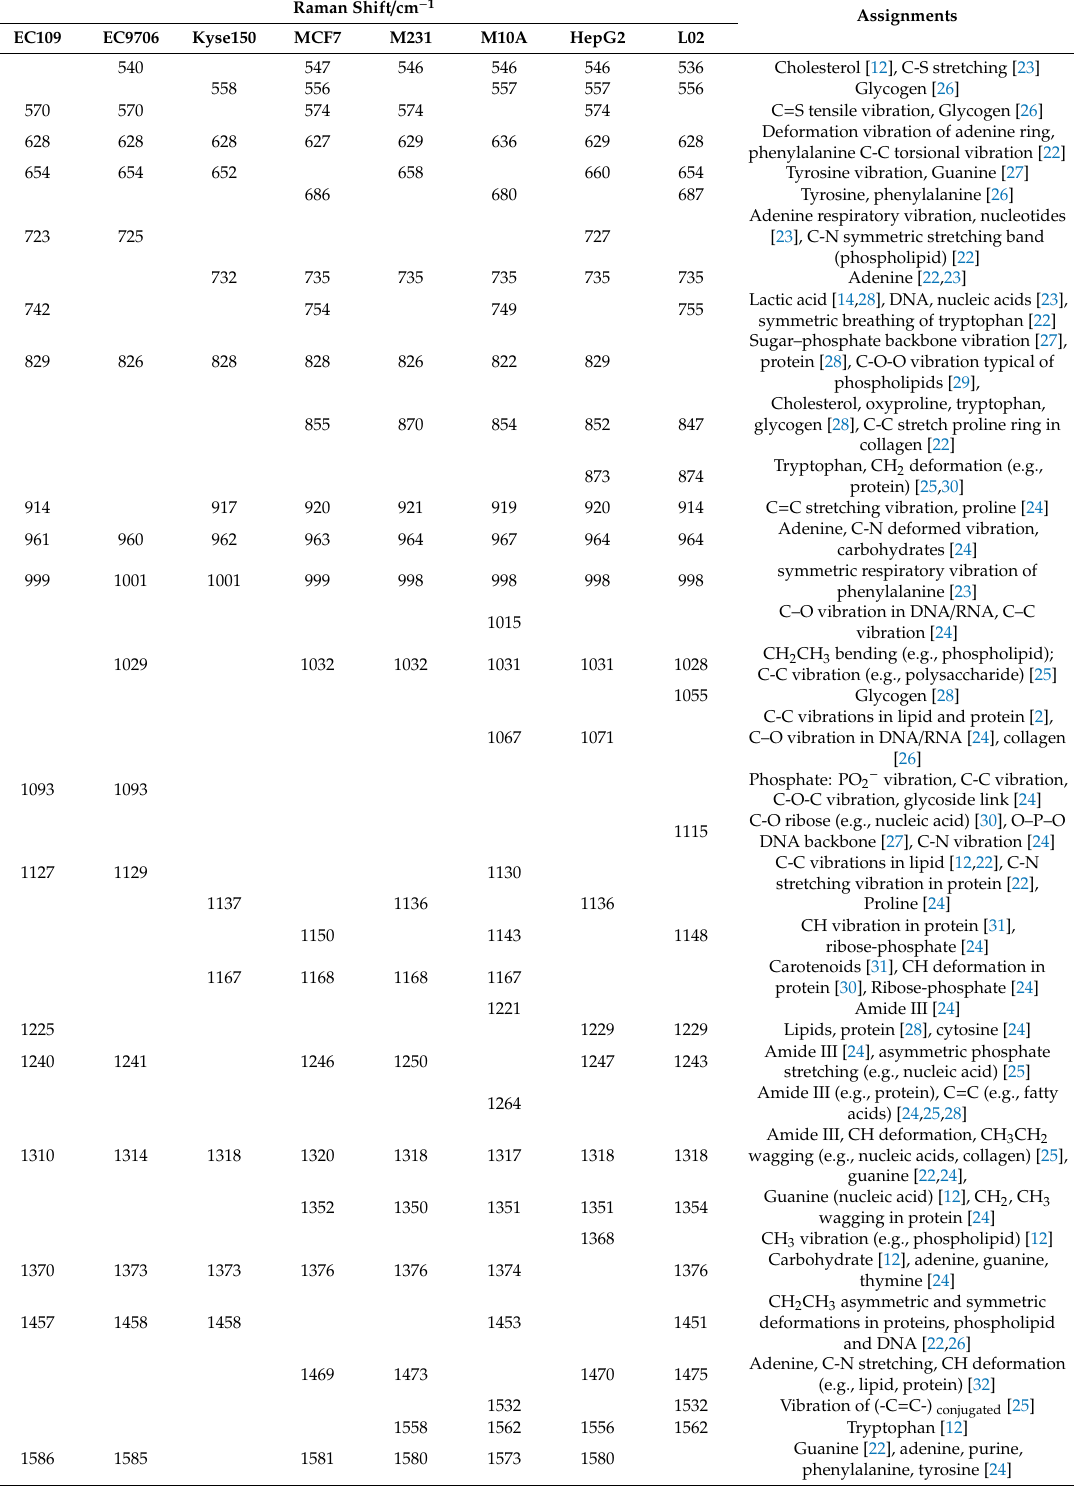
Table 1. SERS peak positions and tentative assignments of the di ff erent cell-derived